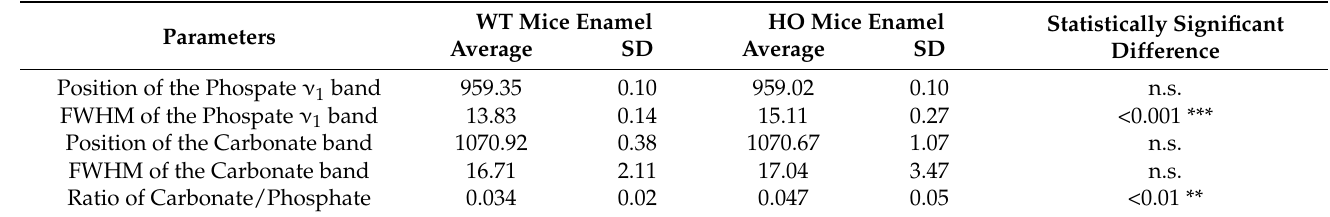
Table 2. Descriptive statistics of the distribution of the normalized Raman parameters of the WT and HO mice